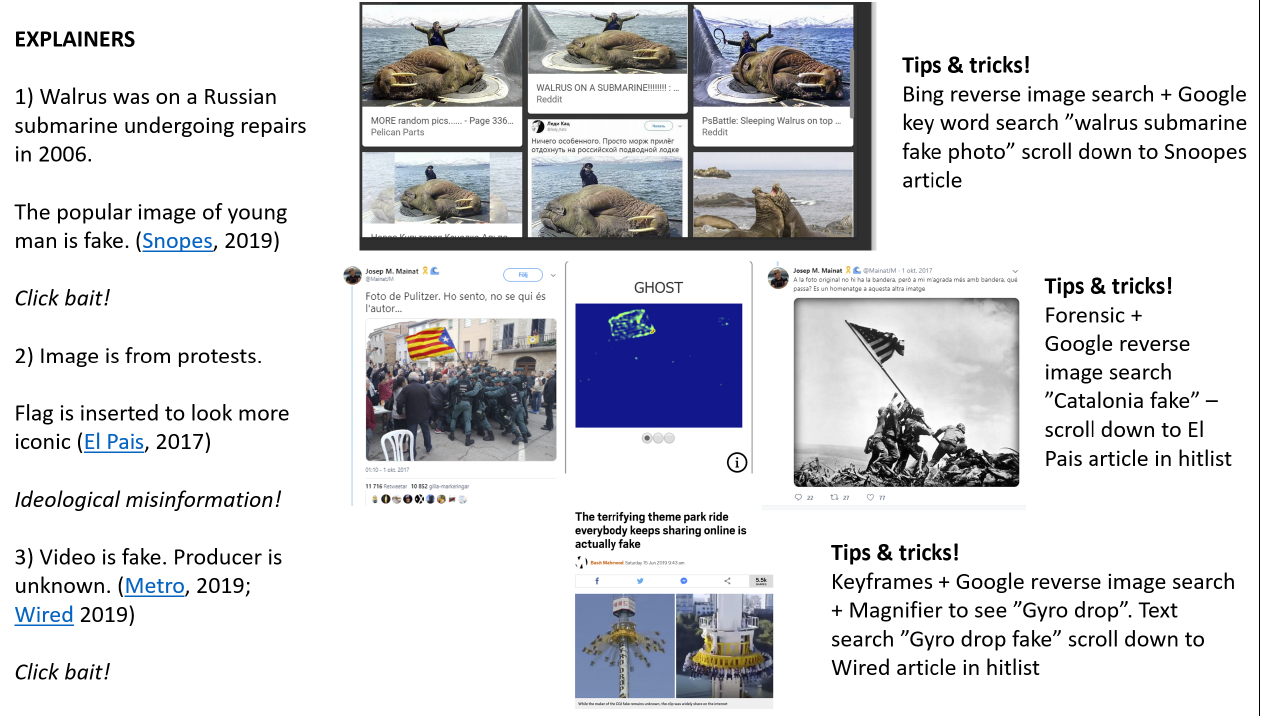
Figure 4. Explainers informing how to debunk fake images and video using